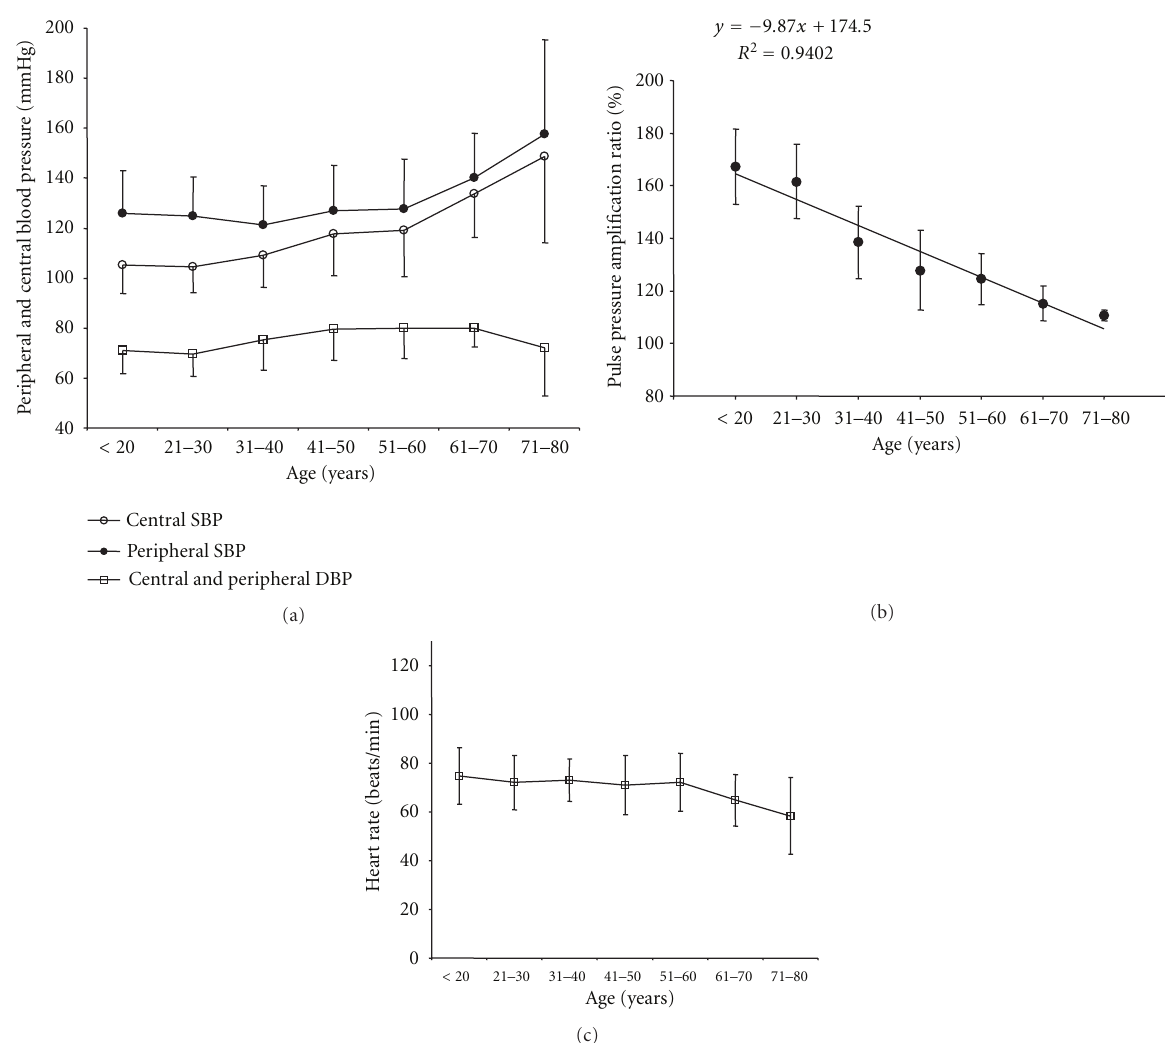
Figure 2: Peripheral (radial) and central (aortic) systolic and diastolic blood pressure (a), pulse pressure amplification ratio (b), and heart rate (c) age- (decade-) related